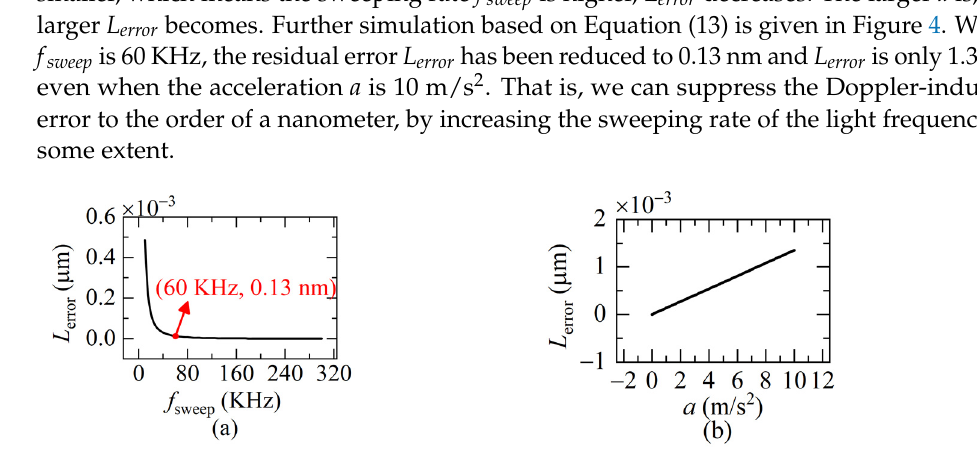
Figure 4. The residual error. ( a ) L error versus sweeping rate; ( b ) L error versus the acceleration a ( Δ u = 5.1 × 10 12 Hz, u a = 1.9365 × 10 14 Hz, v = 0.1 m/s, a = 0.1 m/s 2 , f sweep = 60 KHz).